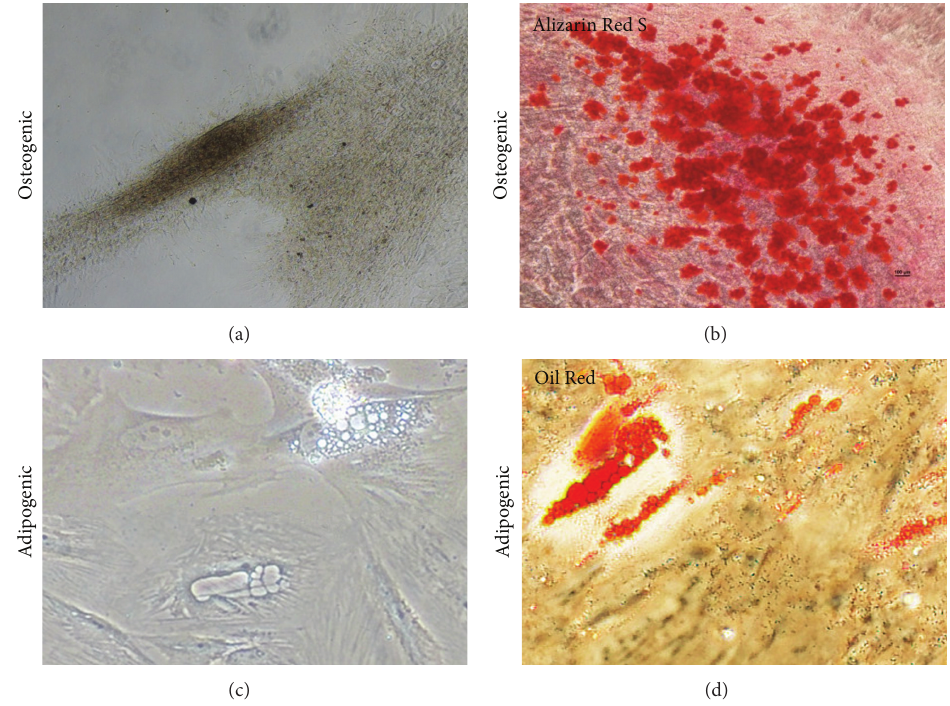
Figure 3: Osteogenic (a) and adipogenic (c) differentiation of hUCMSCs was assessed with Alizarin Red S (b) for osteogenesis and Oil Red O (d) for